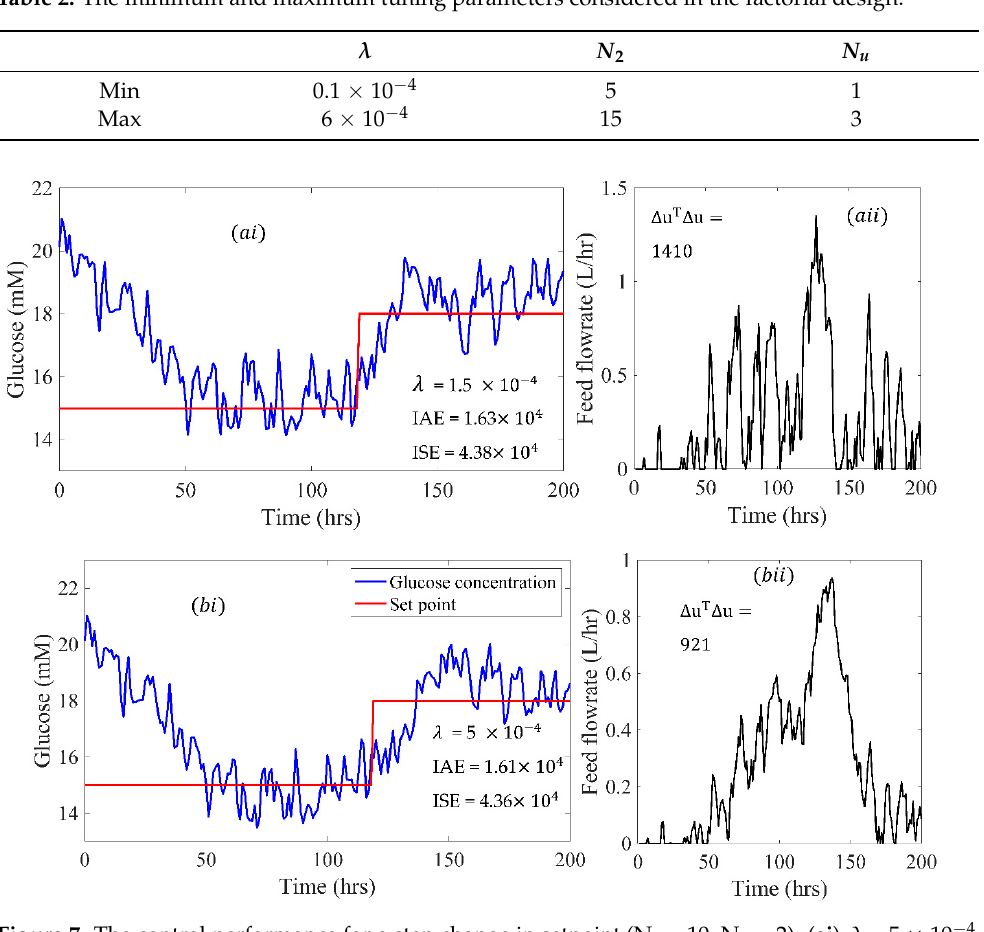
Figure 7. The control performance for a step change in setpoint ( N 2 = 10, N u = 2): ( top row ), λ = 1.5×10 -4 ; ( bottom row ), λ = 5×10 -4 ; ( left column ): controlled variable; ( right column ): manipulated variable.